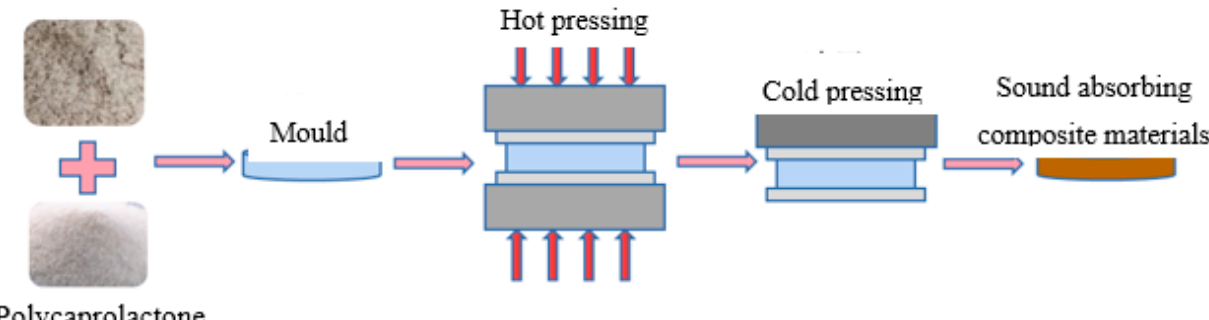
Figure 2. Process flow diagram for the preparation of the sound-absorbing composite materials.